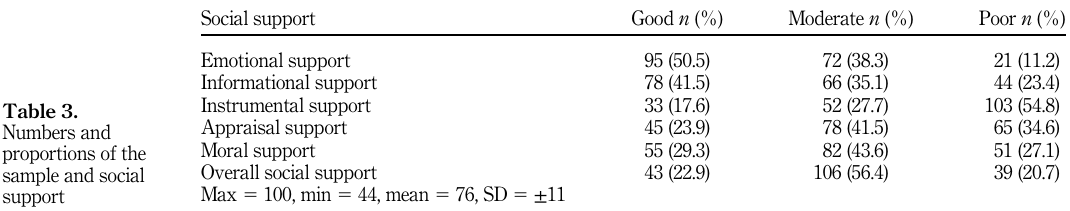
proportions of the sample and social support